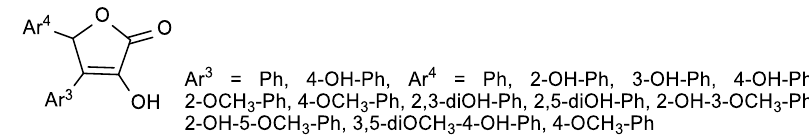
Figure 12. 3,4-Diaryl butenolide derivatives as potential antioxidant and anti-inflammatory agents. Table 8. The antioxidant activity of 3,4-diaryl butenolide. Scaveng. of DPPH Comp. Scaveng. of IC 50 ( µ Comp.